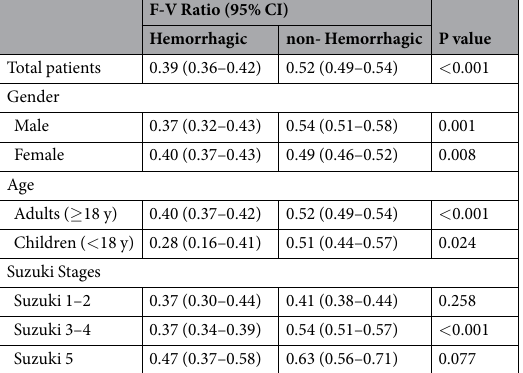
Table 2. The F-V Ratio of Hemorrhagic and non-Hemorrhagic Hemisphere in Different Demographic Groups. Logistic regression (multivariate analysis) was used to analyze the differences of F-V ratio between hemorrhagic and non-hemorrhagic MMD in different demographic groups.